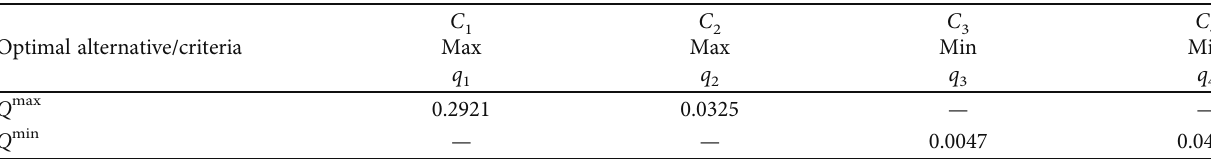
Table 4: Decomposition of the optimal